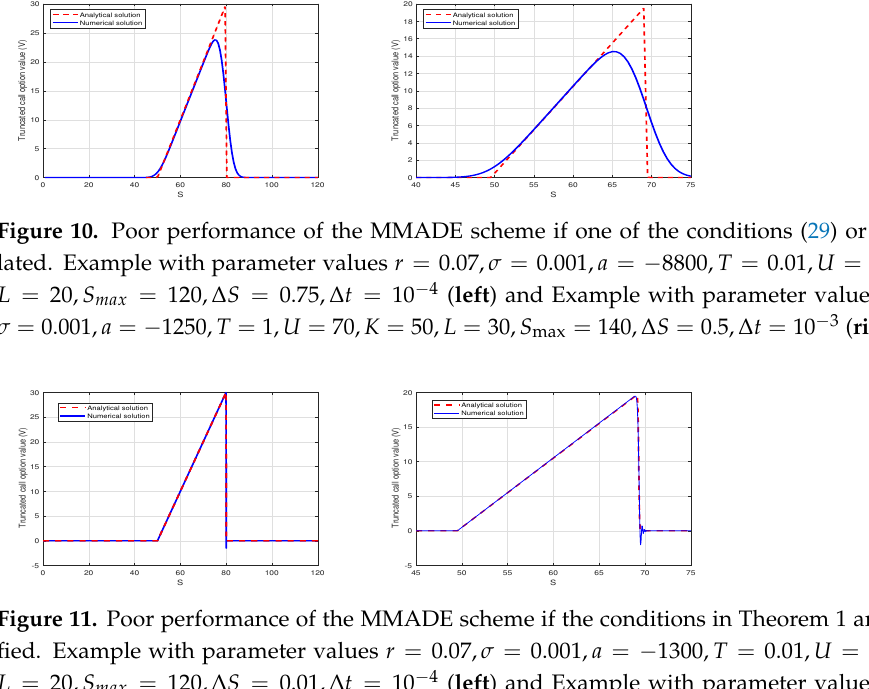
conditions in Theorem 1 are violated, the MMADE scheme shows a poor performance (see Figure 11, for Example 1 (left) and Example 2 (right)).